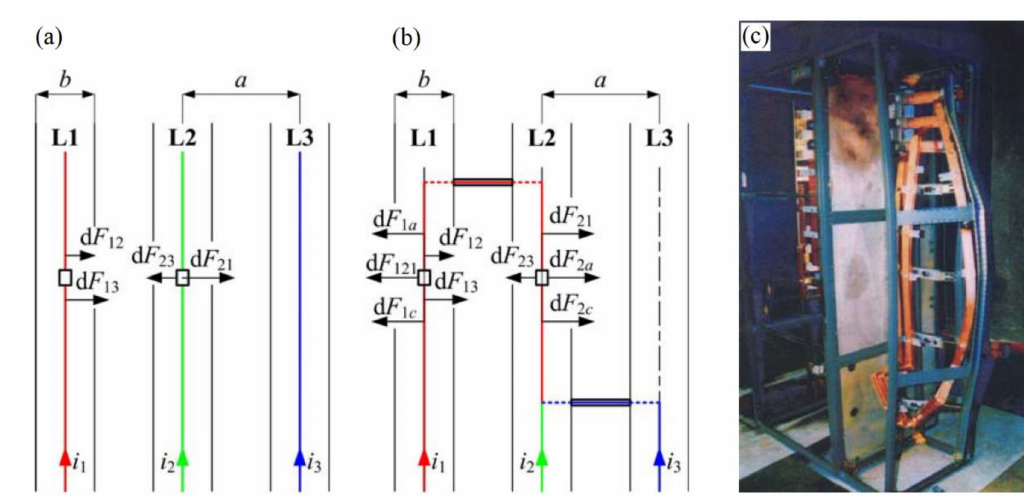
Figure 2. Busbar system in the switchgear after arc fault tests with the distribution of electrodynamic forces acting on individual rails of the flat busbar system at the time of: ( a ) metallic fault; ( b ) arc fault ( c ) damage of the busbar system after arc fault tests in the switchgear